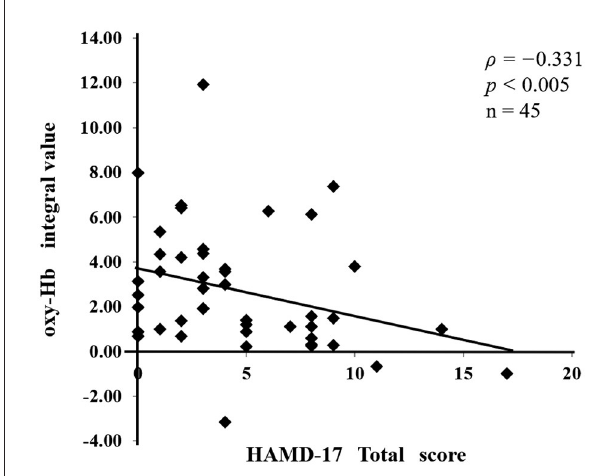
FIGURE 4 | The relationship between the assessment of post-stroke depression (PSD) and the severity of paralysis. A negative correlation ( ρ = − 0.331, P < 0.005) was found between the oxy-Hb integral values and the total 17-item Hamilton Rating Scale for Depression (HAMD17) scores.